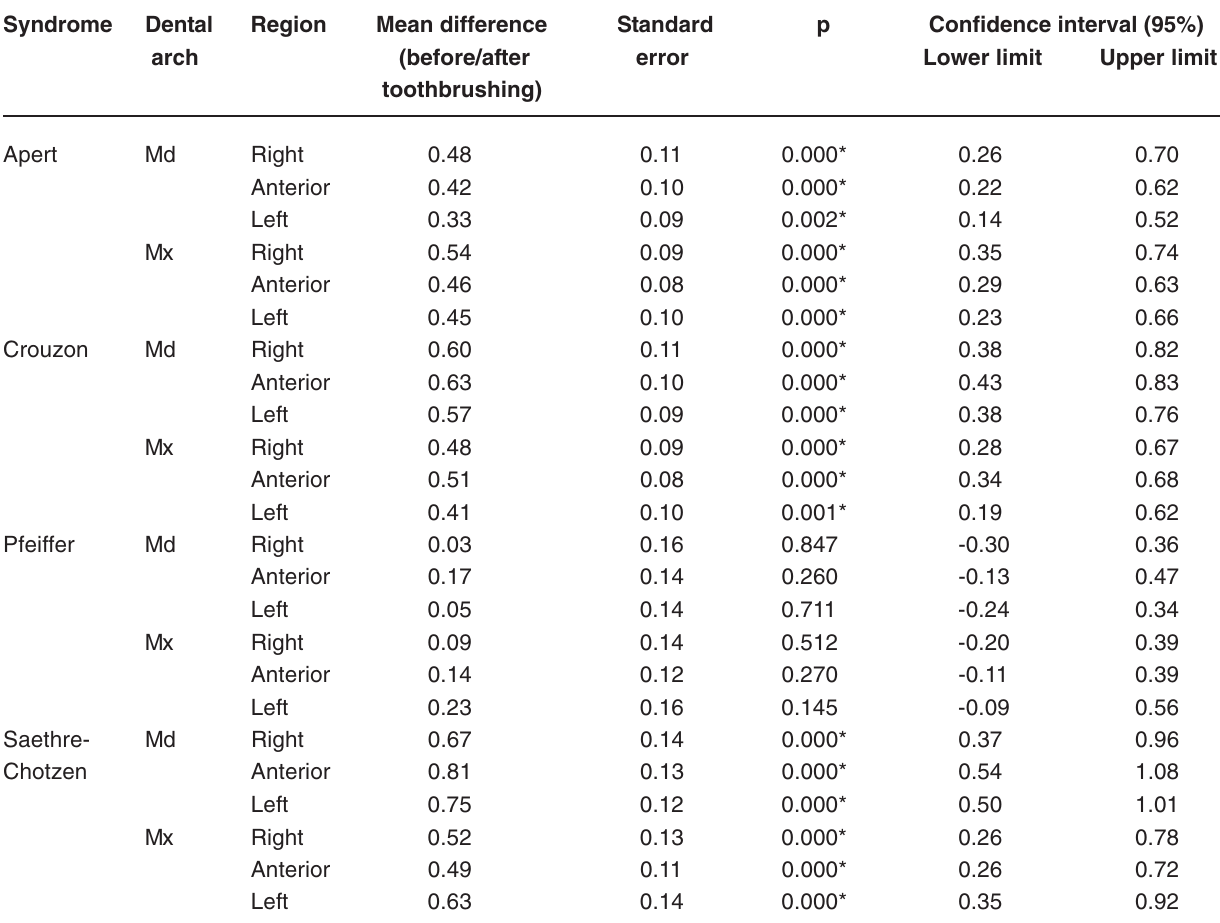
*Statistically significant at p<0.05; Md: mandibular; Mx: